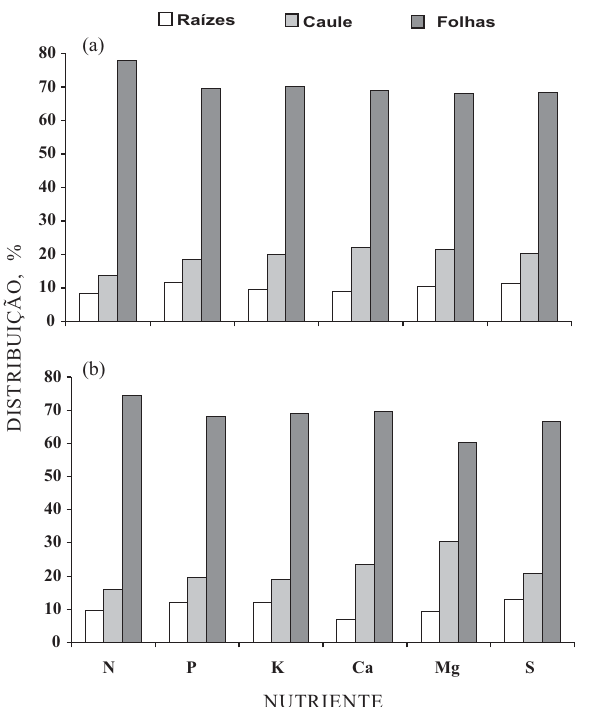
Figura 2. Distribuição dos macronutrientes nos diferentes componentes da biomassa de mudas de goiabeira cultivar Paluma (a) e Século XXI (b), cultivadas em solução nutritiva durante 120 dias após transplantio (médias de quatro